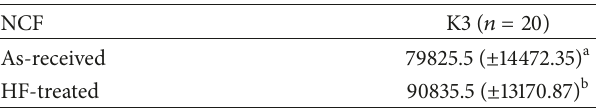
Table 1: The results of fatigue resistance test of HF-treated and as- received K3 instruments.